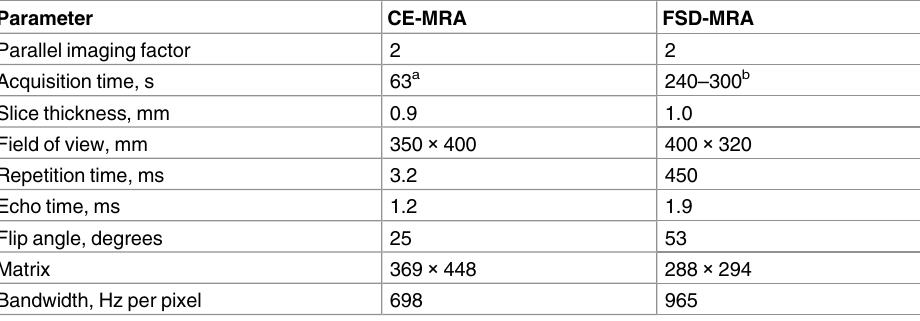
Table 2. Pulse sequence